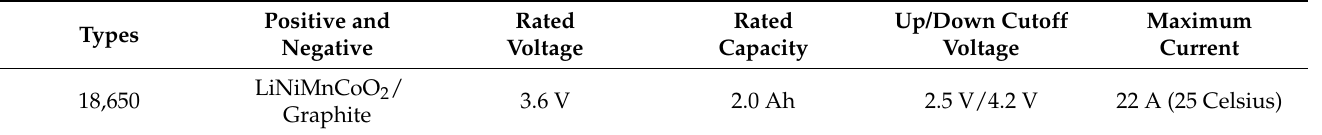
Table 1. Basic specifications of the test samples.